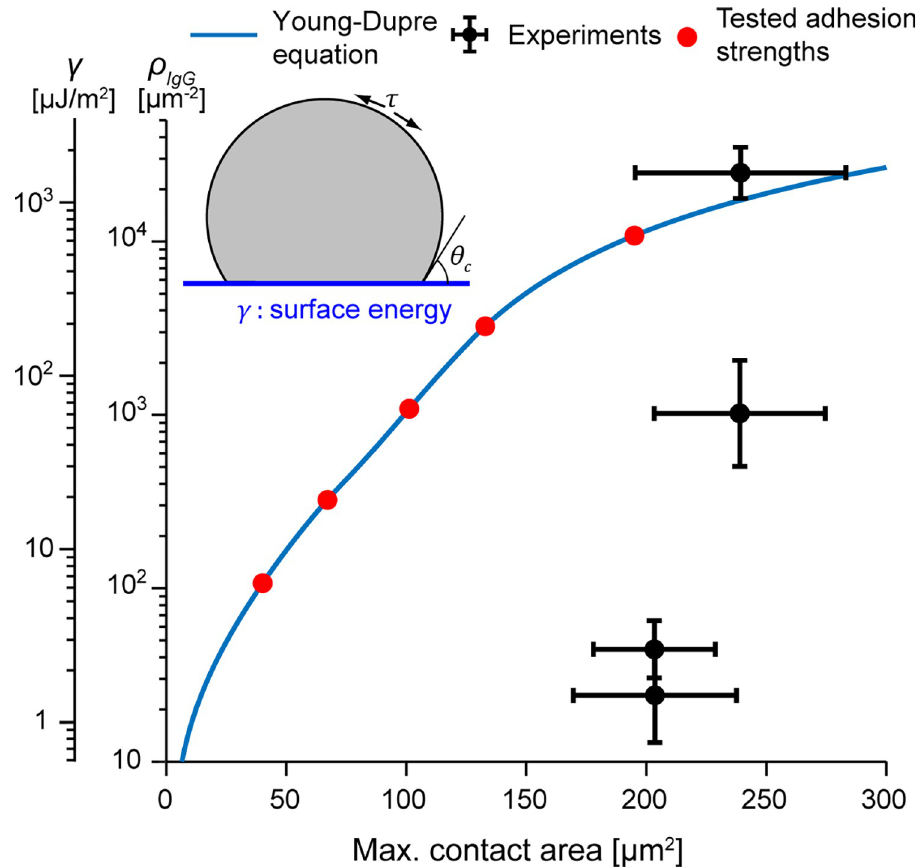
Fig 4. Relationship between ligand density and maximum contact area, as predicted by the Young-Dupre equation. The adhesion energy γ , and therefore the ligand density ρ IgG , can be expressed as a function of the contact area of the final spherical cap formed by a viscous droplet. The tested adhesion strengths are marked as red dots. Actual experimental values are shown for comparison. Error bars indicate standard deviation.